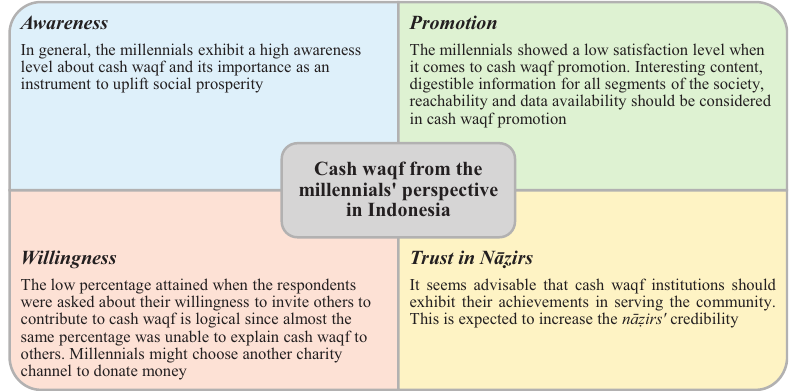
Figure 1. Summary of the four aspects considered under this